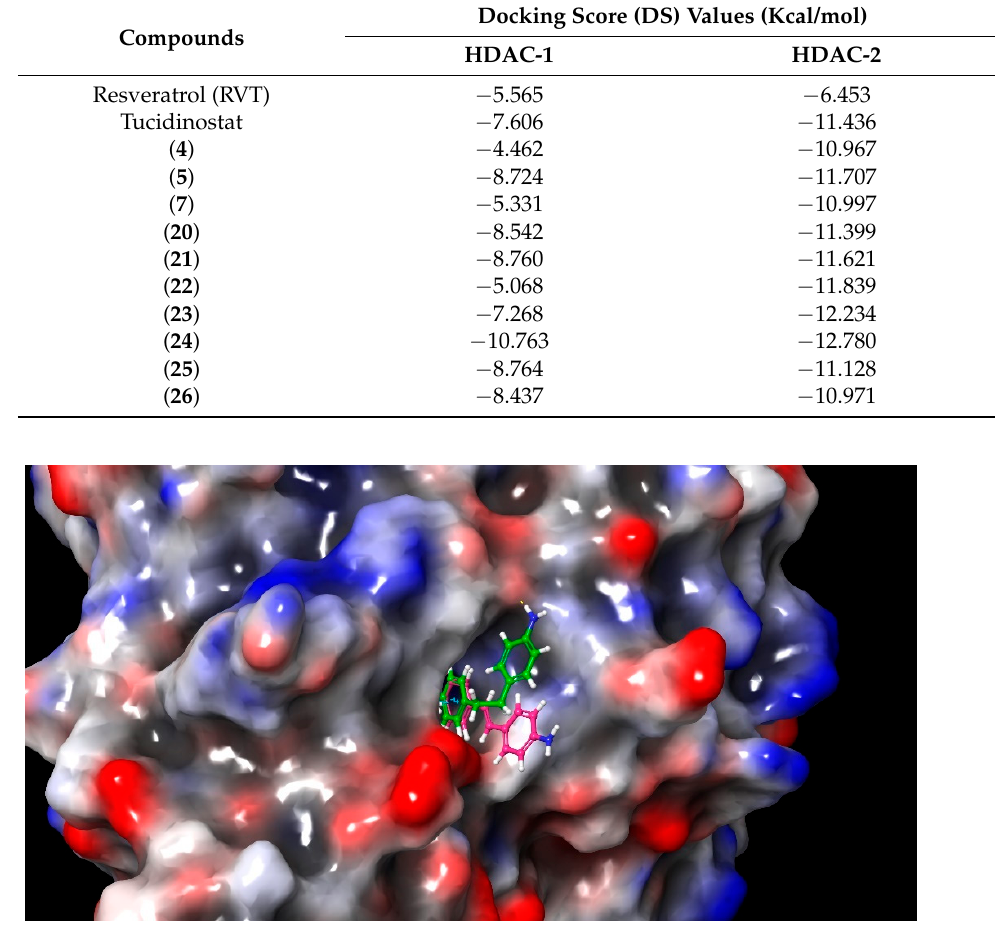
Figure 6. Superposition of compounds ( 4 ) and ( 5 ) in the active site of